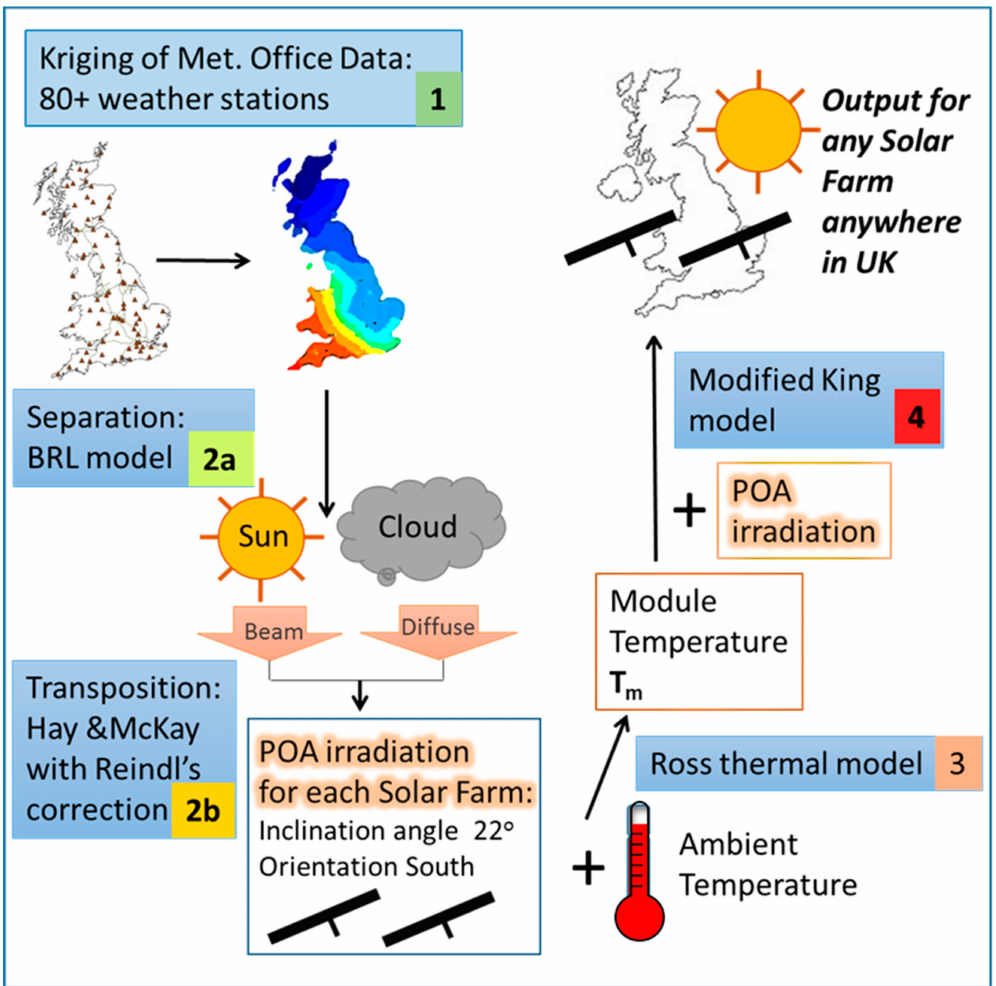
Figure 1. Summary of stages involved in generation of solar farm